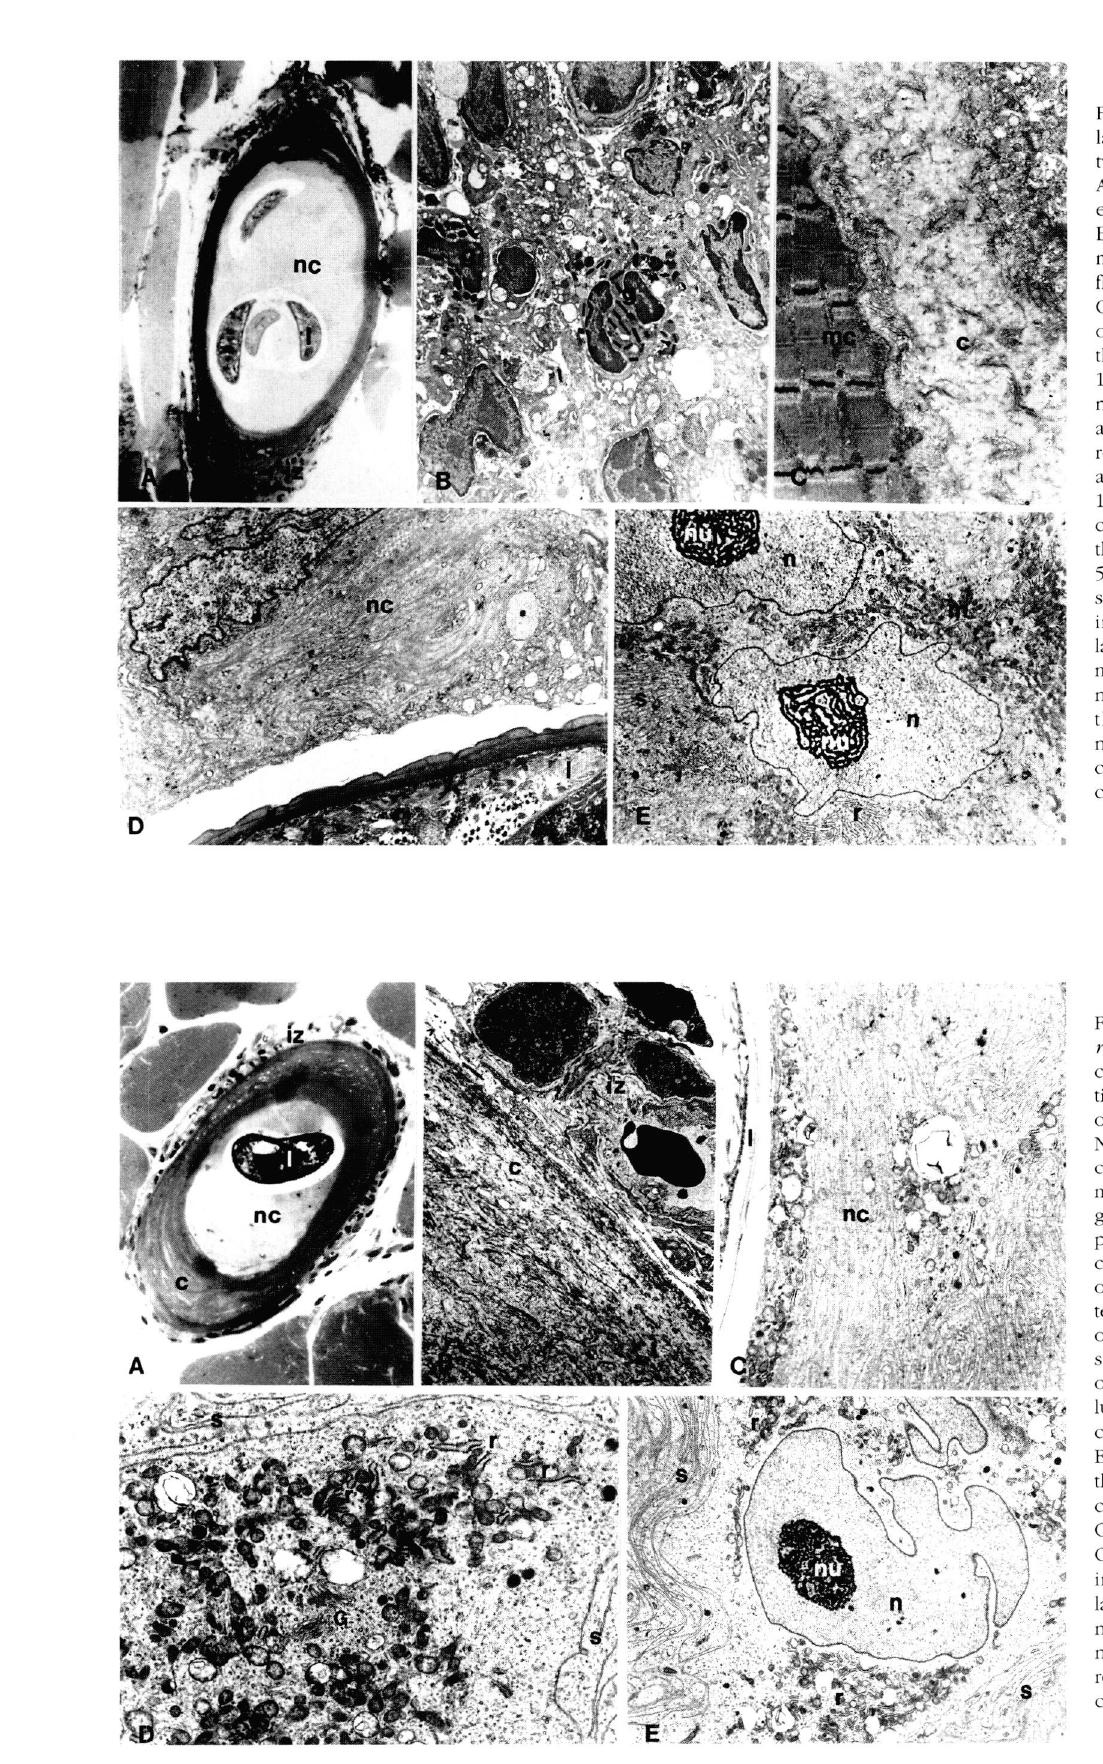
Fig. 2. - Trichinella spi ralis larvae in human mus­ cles 16 months after infec­ tion. A) Transverse section of an encapsulated larva. Note the thickness of the capsule (x 1,250); B) trans­ mission electron micro­ graph (ТЕМ) of the peri­ pheral zone of the collagen capsule (x 9,700); С) ТЕМ of the nurse cell-larva in­ terface (X 9,700); D) ТЕМ of a detail the nurse cell showing a large amount of smooth and rough reticu­ lum, vesicles, and Golgi complexes (x 14,000); E) ТЕМ of a nucleus of the nurse cell in the trans­ criptional phase (x 5,500). С = collagen capsule, G = Golgi complex, iz = inflammatory zone, 1 = larva, nc = nurse cell, n = nucleus of the nurse cell, nu = nucleolus, r = rough reticulum, s = smooth reti­